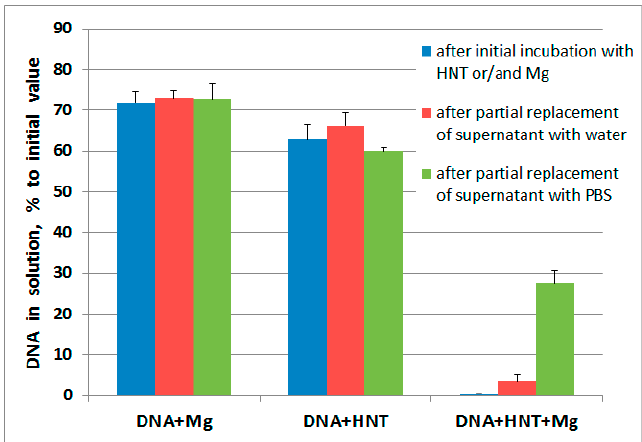
Figure 2. Ultrasonicated DNA content in solution after incubation with halloyste nanotubes or/and